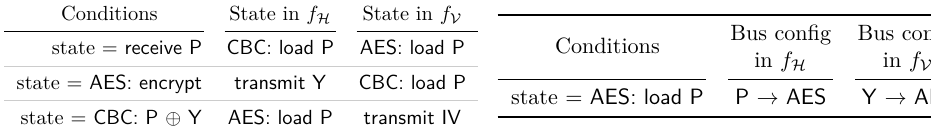
Table 2: Introduced changes in the visible functionality to the FSM state transitions (left) and bus address decoding